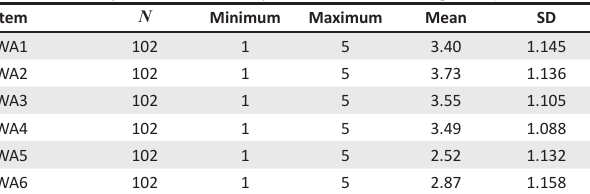
TABLE 12: Descriptive statistical analysis (Section C – performance